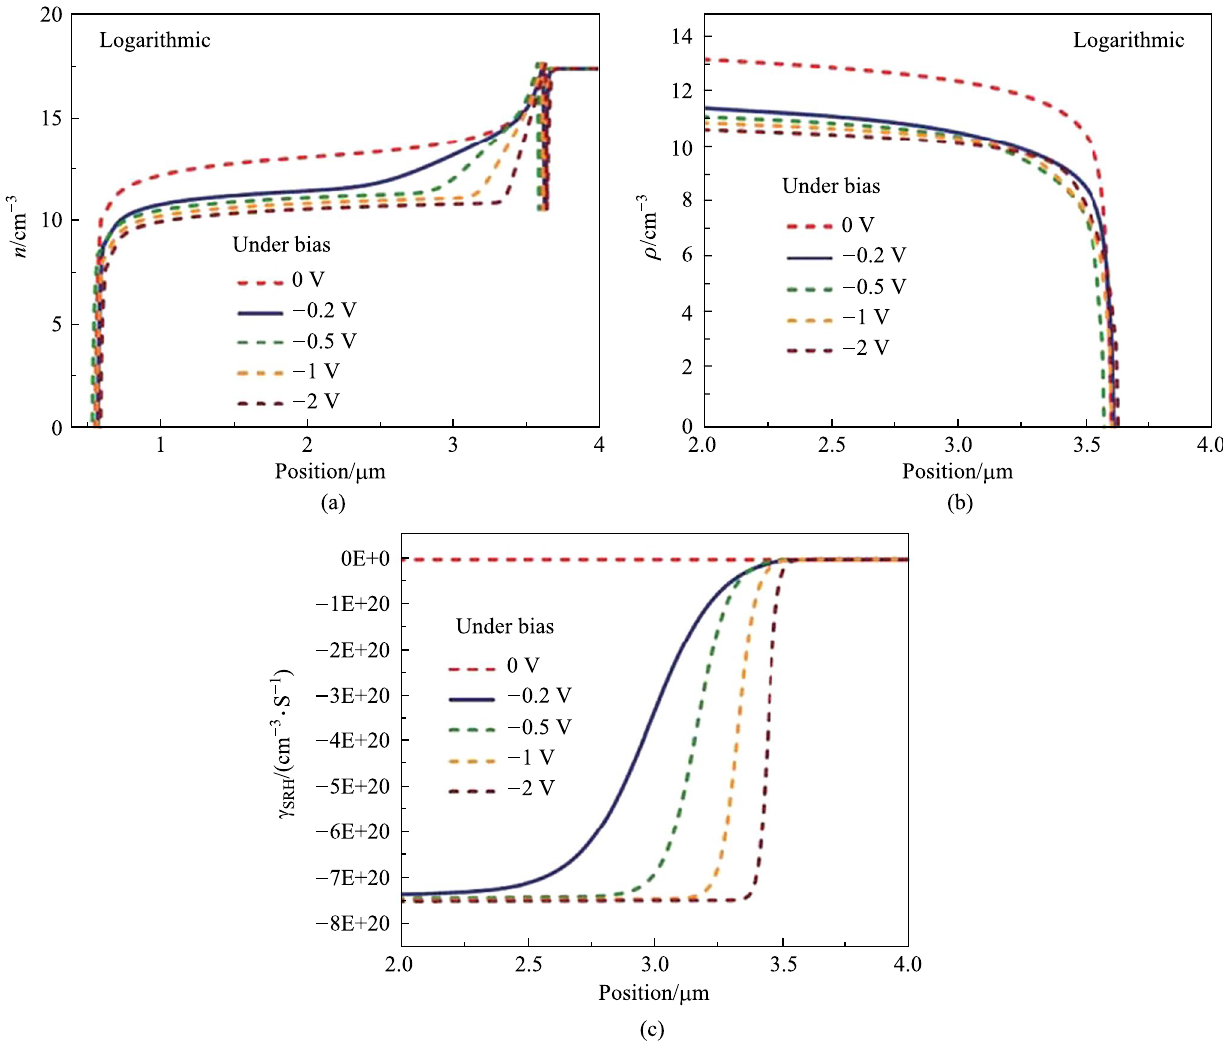
Plots of the results in the absorber layer of the δ-DCGB nBn-PD device as function of the position at various applied bias voltages. a Electron density. b Hole density. c SRH recombination rates (negative value means